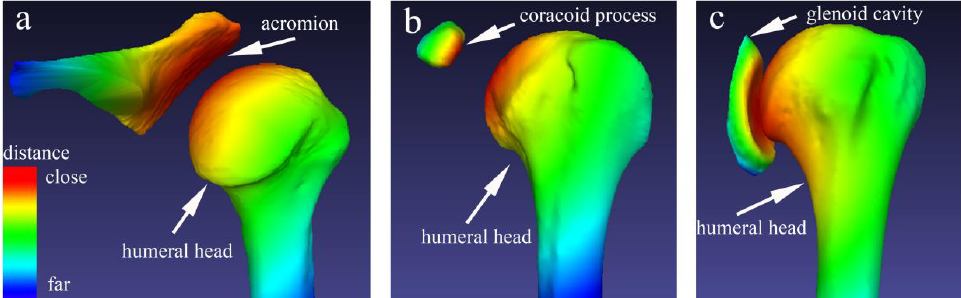
Figure 4. Representative determination of the minimum distance in the 3D surface models. The red areas indicate where ( a ) the acromion, ( b ) the coracoid process, and ( c ) the glenoid with the minimum distance from the humeral head. The sequential color change process from red to yellow, green, and blue represents a gradual increase in the distance between the two surface models. The minimum distance indicates that any point in the acromion, coracoid process, and glenoid cavity surface model can be reached at any point in the humeral head surface model which was automatically calculated. (Not-to-scale).